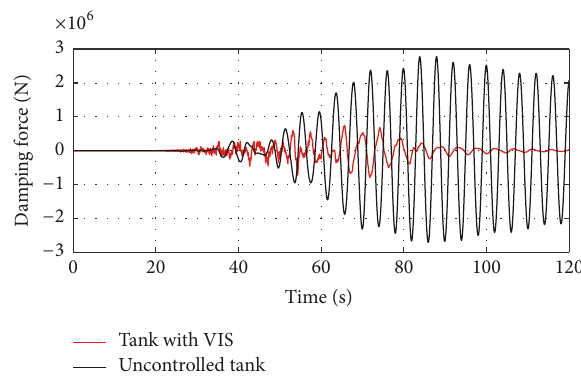
Figure 20: Output forces of the tank with the VIS and the uncontrolled tank under the excitation of the Chi-Chi earthquake.